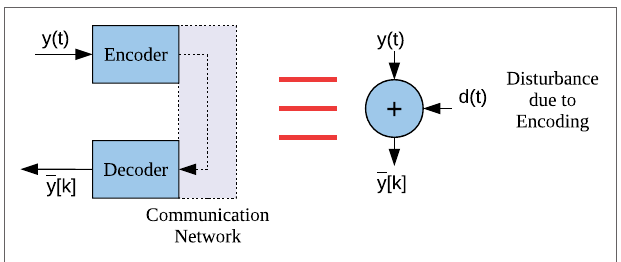
FIGURE 2 | Reconstruction error modeled as a disturbance